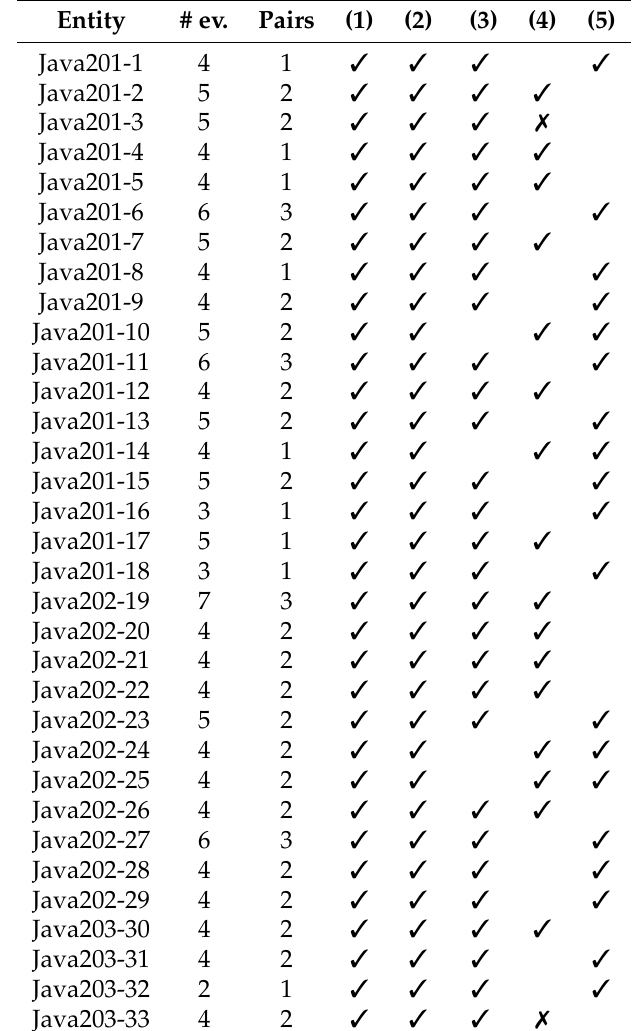
Table 10. Results of expert judgment for classes in Java programming language, with assessed quality aspects, overall quality (1); source code size (2); class complexity (3); class cohesion (4) and class coupling (5); based on an evaluation using a combination of software